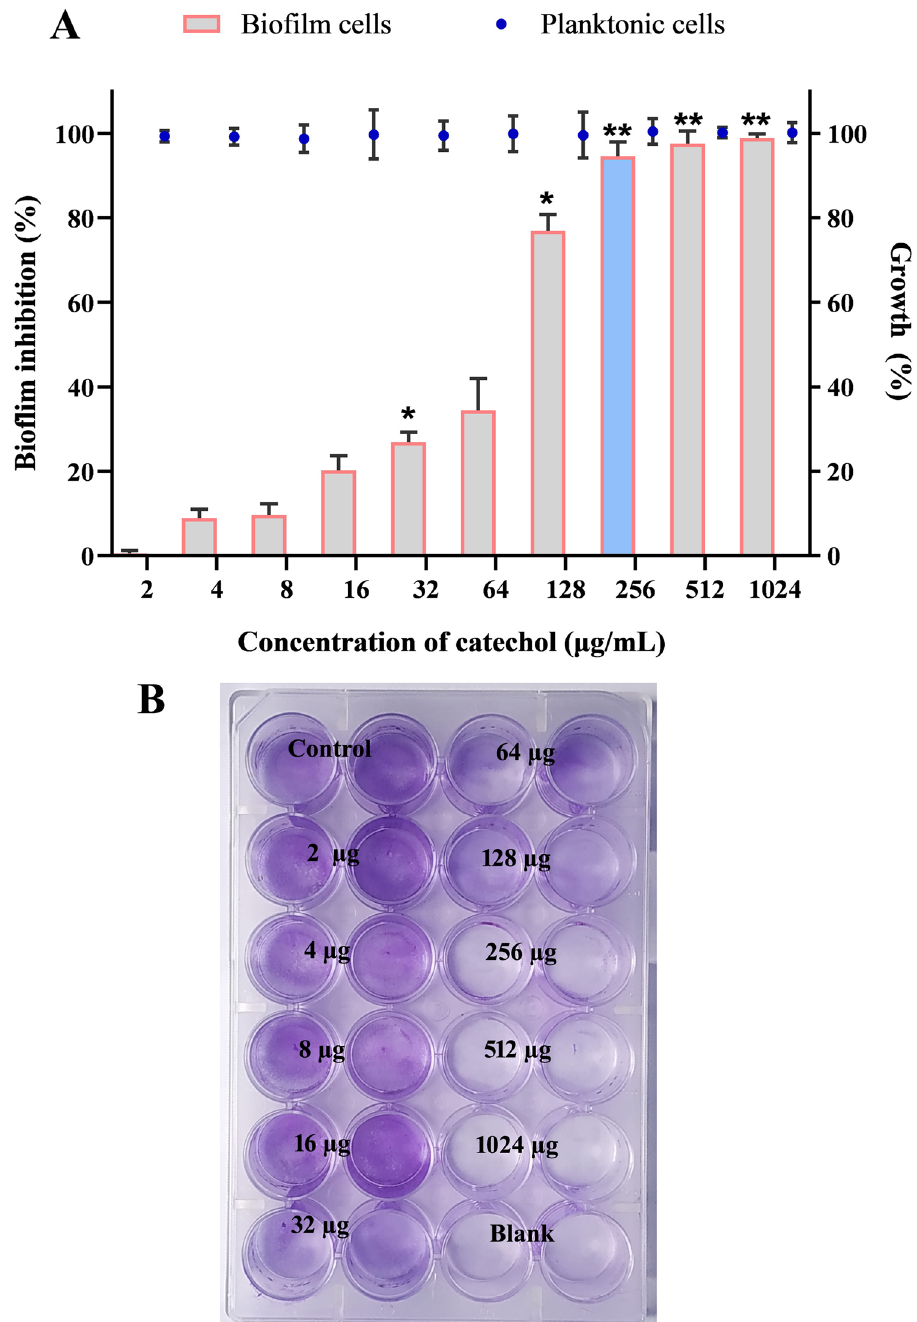
Figure 4. Antibiofilm efficacy of catechol at varied concentrations. ( A ) Measurement of biofilm formation and planktonic growth in presence of catechol at various concentrations. Significant dose dependent reductions of biofilm formation were observed in the cells treated with catechol compared to untreated control without affecting the C. albicans planktonic growth. Blue colored bar in the graph signifies the BIC value of catechol. Error bars indicates the mean values of three experimental triplicates. The “* “and “**” symbols represents the statistical significance of p < 0.05 and p < 0.01, respectively. ( B ) Representative MTP image that portraying the impact of catechol on C. albicans